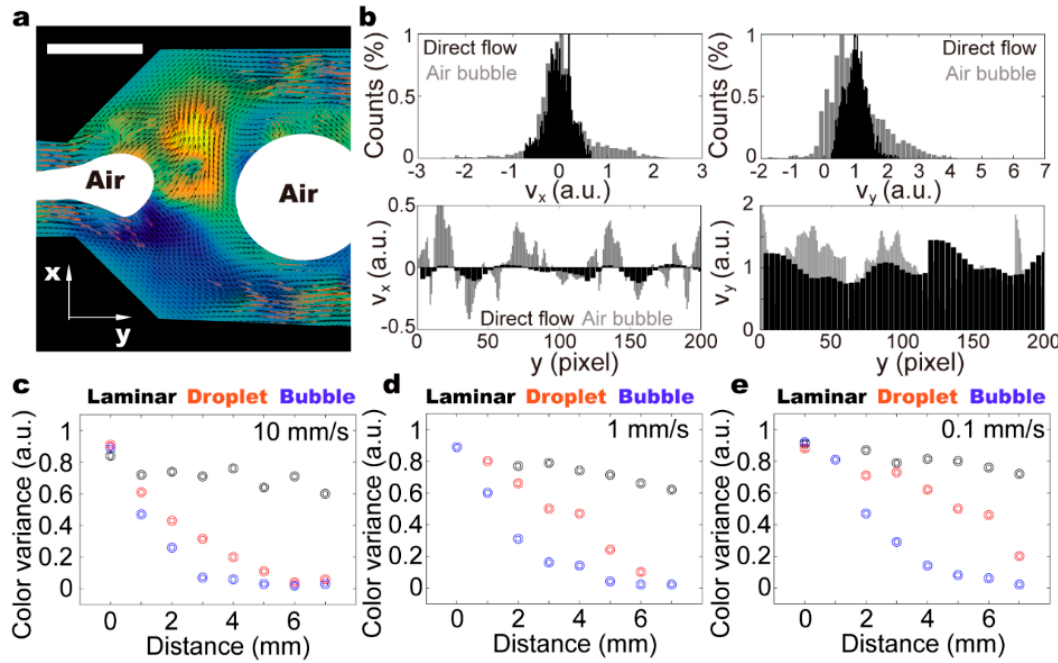
Figure 5. ( a ) Turbulent flow generated with the presence of air bubbles on-chip. ( b ) Flow distribution within the channels demonstrates that air bubbles as stirrers substantially enhance the flow rate in cross-sectional direction of the channel, which allows for fast mixing. The flow velocity is normalized to the driving flow rate to illustrate the mixing efficiency. ( c – e ) Color variances are measured in the cross-section at different positions along the fluidic channel (i.e., distance from the Y-junction). To obtain the color variances, light intensities of selected area along the fluidic channel are measured in the red channel of the RGB picture, and calculated to get the standard deviation (Figure S3). Three different driving flow rates (i.e., 10, 1, and 0.1 mm/s) are analyzed. The scale bar denotes 500 μ m.